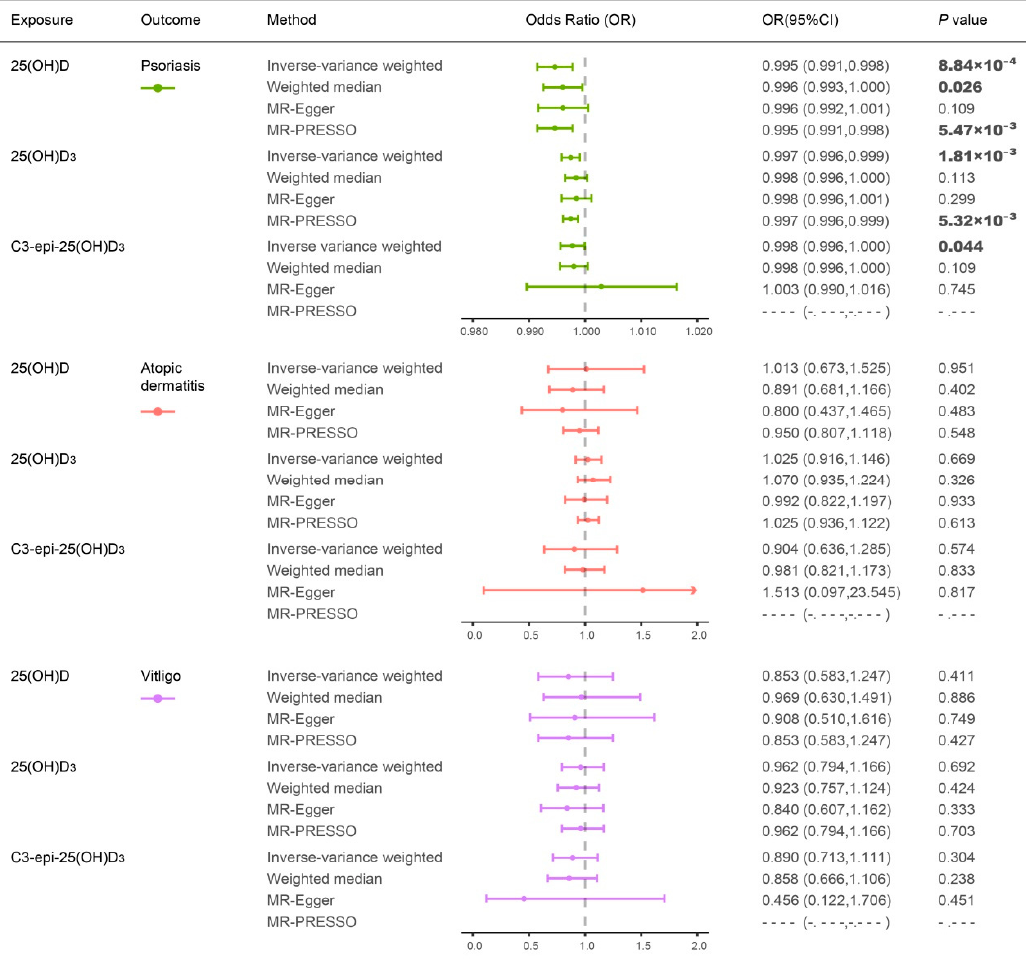
Figure 1. Causal estimates of vitamin D levels on the risk of psoriasis, atopic dermatitis, and vitiligo. The significant p values at p < 0.05 are in bold. Abbreviations: 25(OH)D: 25-hydroxyvitamin D; 25(OH)D 3 : 25-hydroxyvitamin D 3 ; C3-epi-25(OH)D 3 : C3-epimer of 25-hydroxyvitamin D 3 ; MR: Mendelian randomization; MR-PRESSO: Mendelian randomization pleiotropy residual sum and outlier test; OR: odds ratio; CI: confidence interval.